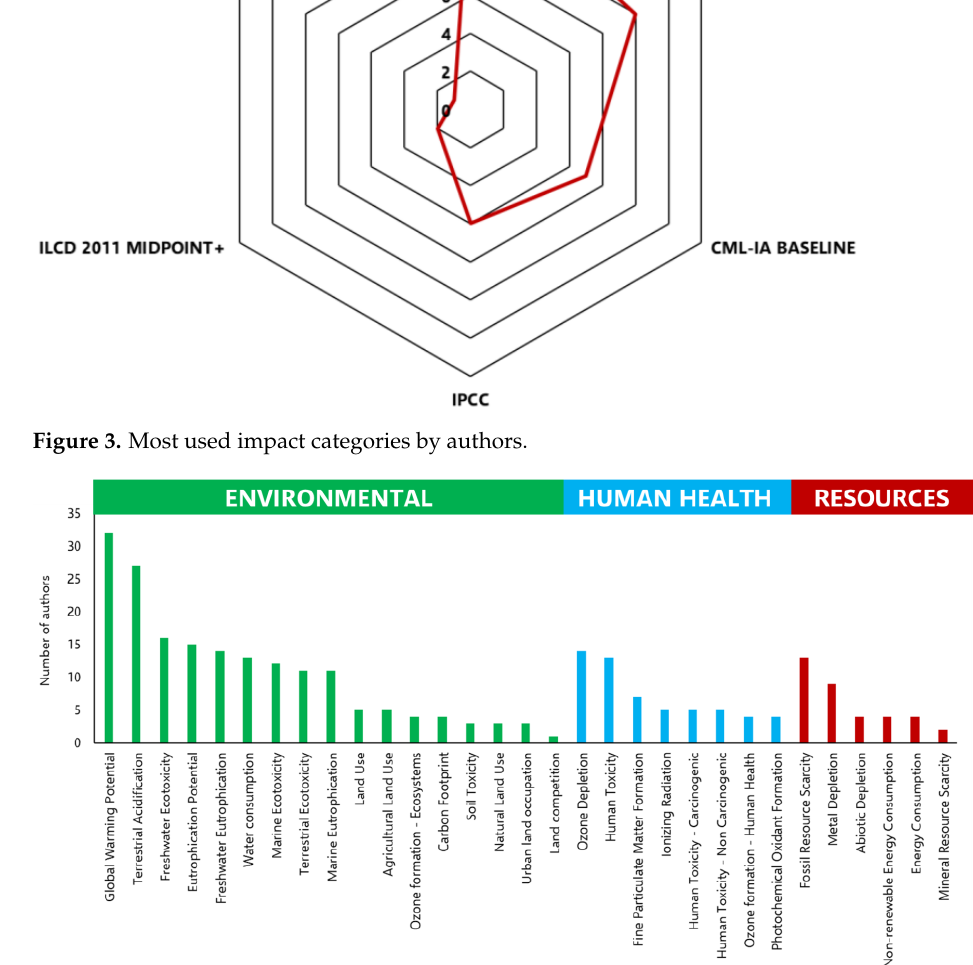
Figure 3. Most used impact categories by authors.